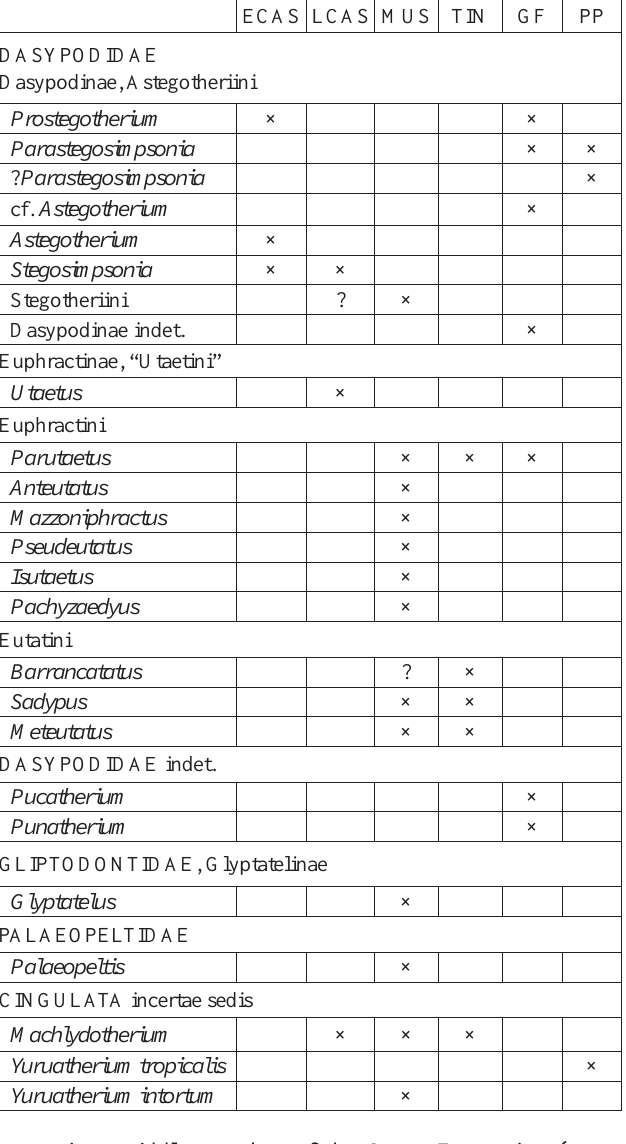
dle Eocene; MUS, Mustersan SALMA, middle–late Eocene; TIN,